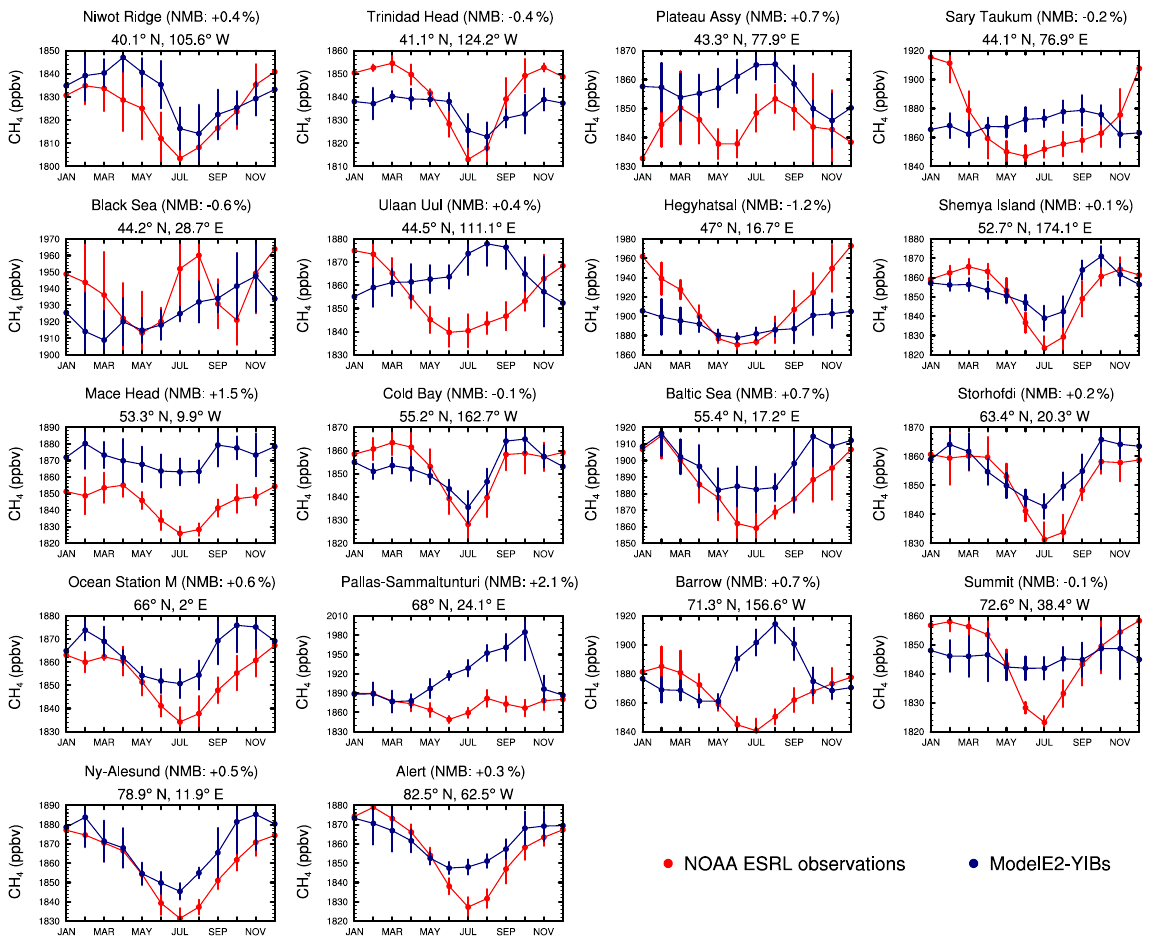
Figure 5. Annual cycle of surface methane concentration (ppbv) at 50 locations for both the E2005 simulation and the NOAA ESRL measurements. The filled circles represent monthly means, and the vertical bars represent ± 1 standard deviation. The scale varies by panel. The normalized mean bias (NMB, %) calculated using monthly means is indicated in the panel